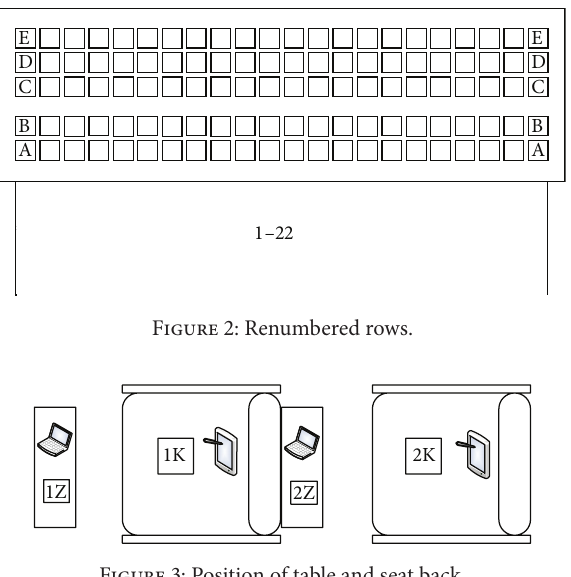
Figure 3: Position of table and seat back. Table 1: The path loss values of 16th–20th rows